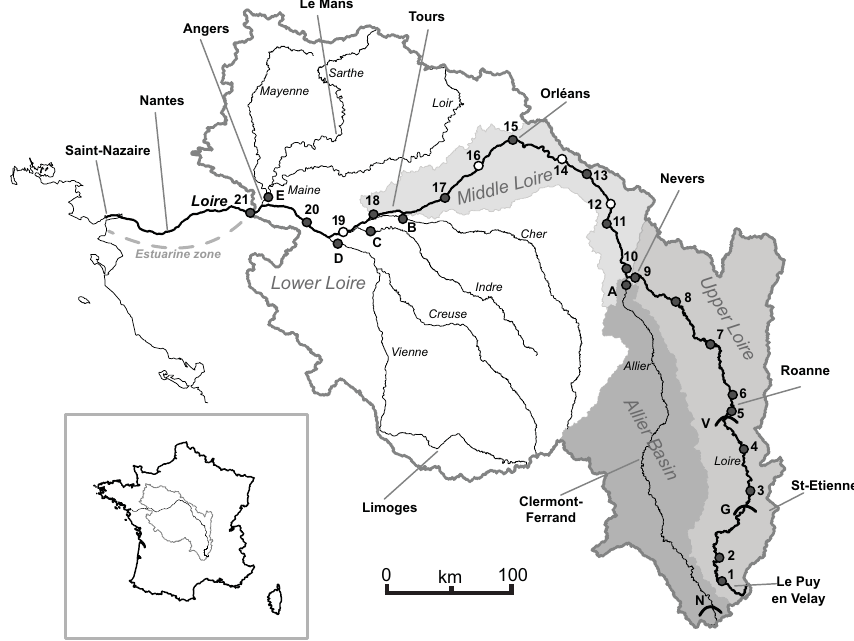
Figure 1. Loire River basin. Dark circles: sites of regulatory surveys. White circles: Nuclear Power Plants sampling sites. A to E: regulatory survey stations at tributaries outlets. G, V, N: three major dams, respectively Grangent, Villerest and Naussac. The estuarine influence begins downstream of station